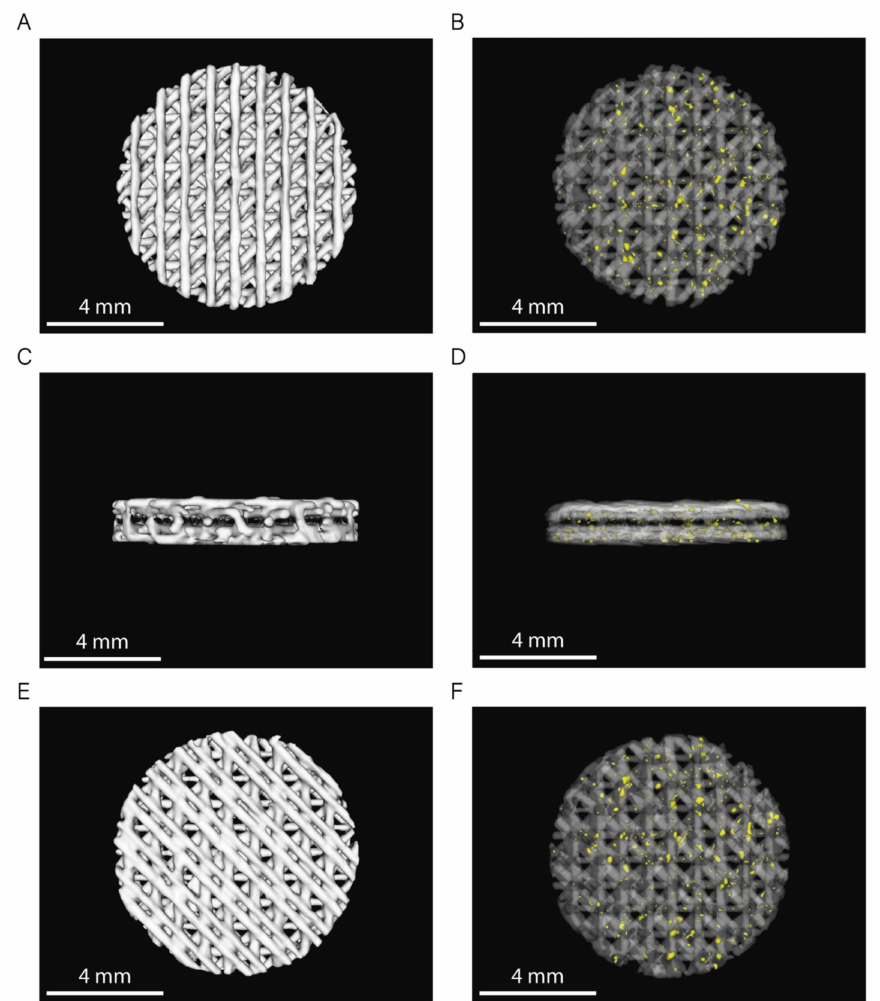
Figure 3. 3D rendering of PCL and PCL/ β -TCP scaffolds (top: ( A , B ); lateral: ( C , D ); and bottom: ( E , F ) view). In images ( B , D , F ), PCL is shown with 80% transparency to allow the observation of the β -TCP particles, which are depicted in